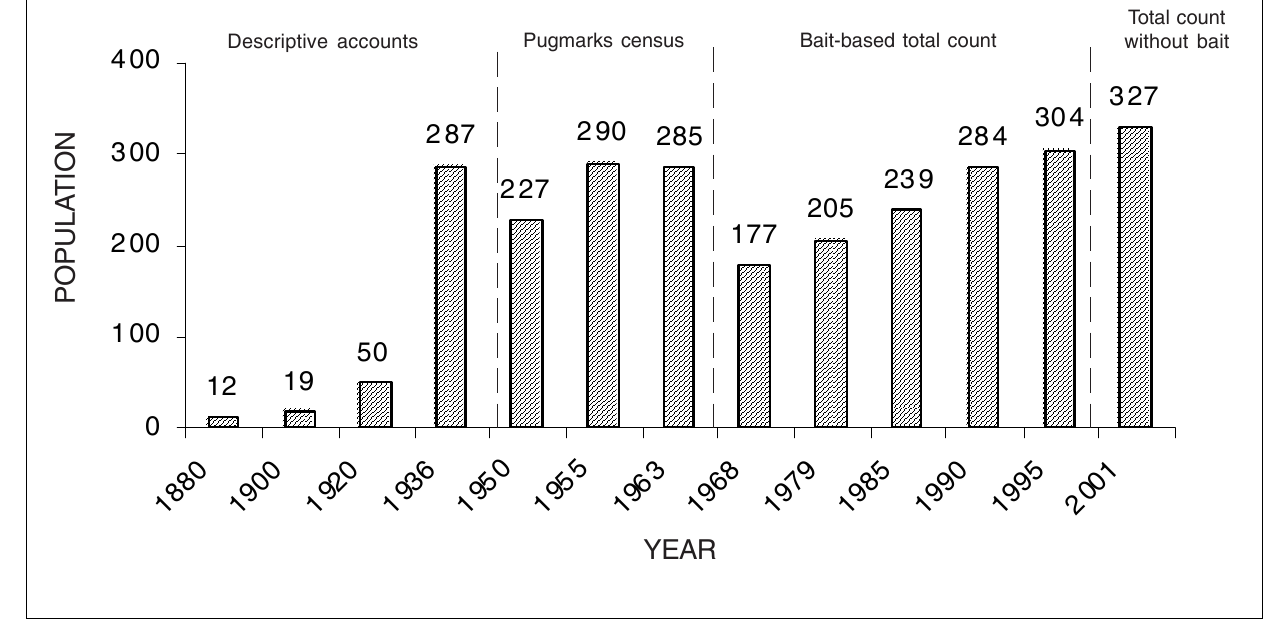
Figure 3. Population fluctuation of Asiatic Lion from the year 1880 to